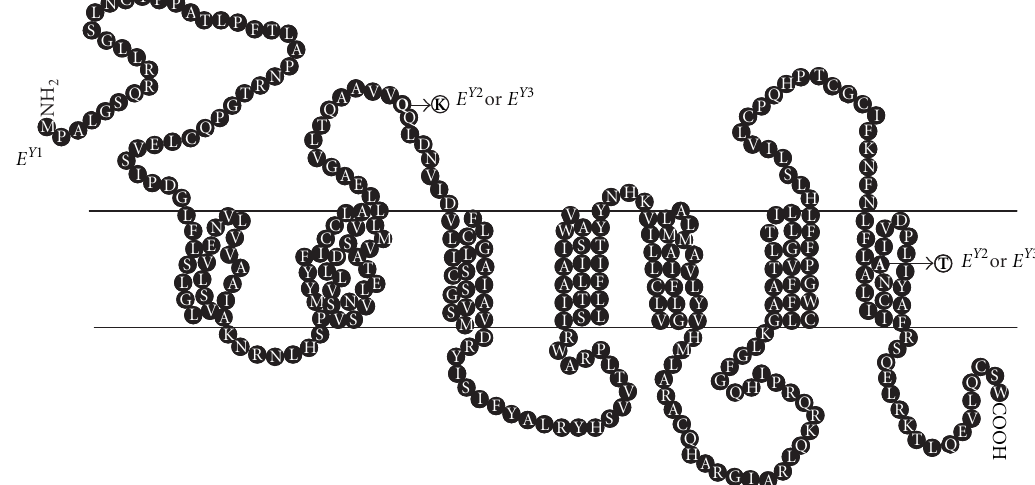
Figure 4: Hypothetical structure of the yak MC1R protein with the two amino acid changes identified in this study. Amino acid changes are scored relative to the E Y 1 haplotype. Transmembrane domains were predicted using the TMpred program [25], with reference to the reported cattle MC1R